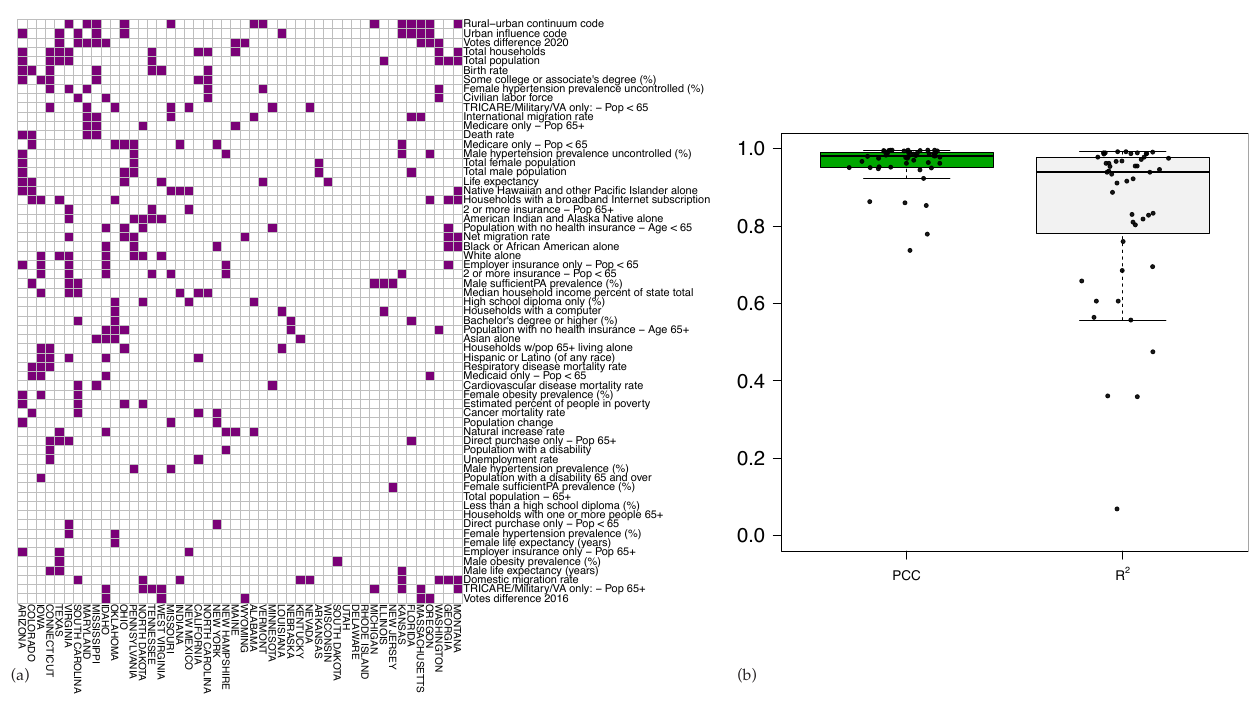
Figure A3. ( a ) Selected predictive features for each state by the algorithm for the initial phase prediction of cases. ( b ) PCC and R 2 values of the predictions reported as a box plot.